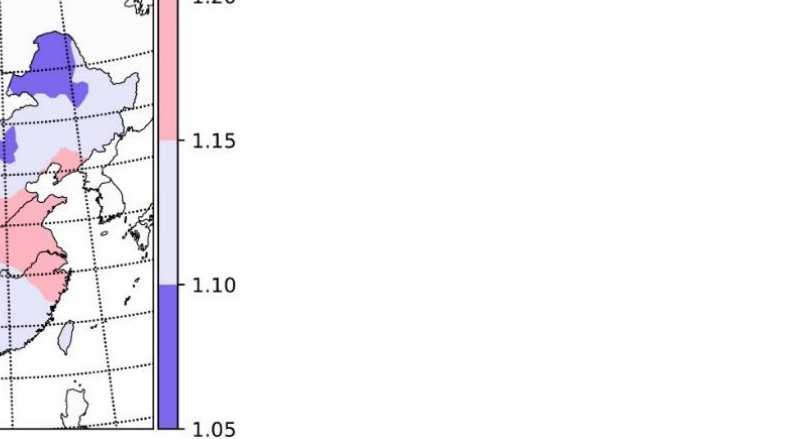
Figure 6. Spatial distribution of the power-law distribution means exponent β of precipitation quiet time in eastern China.